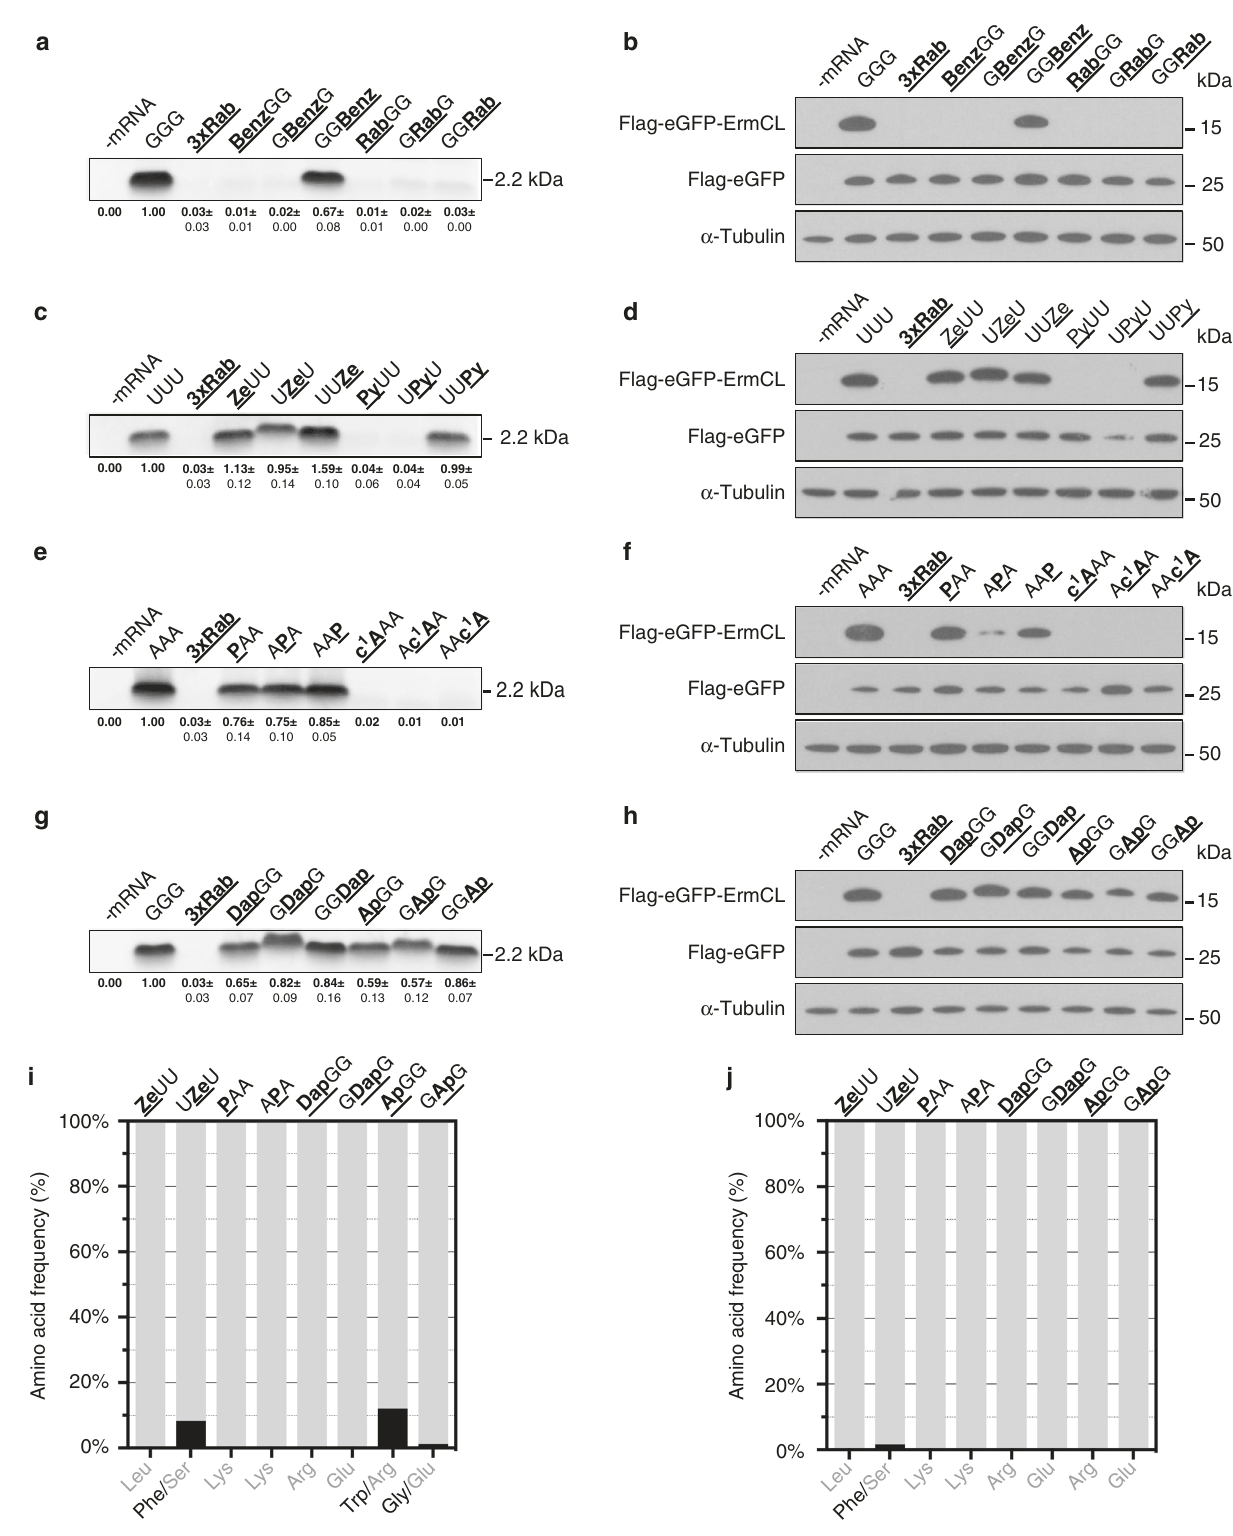
Fig. 2 Translation of mRNAs carrying non-standard nucleotides. Left panel a , c , e , g : Autoradiography of ErmCL peptides synthesized using the bacterial in vitro translation system. Right panel b , d , f , h : Western blot analyses of modi fi ed mRNAs translated in HEK293T cells. An unmodi fi ed eGFP mRNA and α - tubulin served as an internal transfection control and as a loading control, respectively. Amino acids incorporated at the respective positions of peptides puri fi ed from i the E. coli translation system and j HEK293T cells were analyzed by mass spectrometry. Error bars depict the SDs from the mean of at least three independent